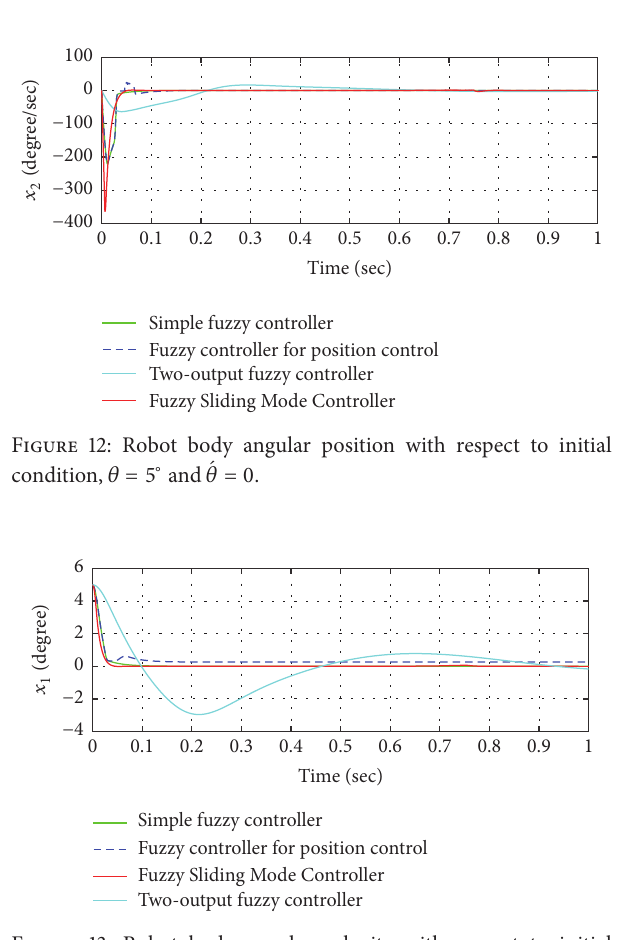
Figure 13: Robot body angular velocity with respect to initial ́𝜃 = 0 condition, 𝜃 = 5 ∘ and